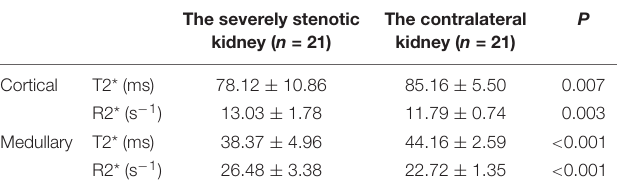
TABLE 2 | BOLD-MRI comparison of the affected kidney and contralateral kidney in patients with unilateral ARAS.